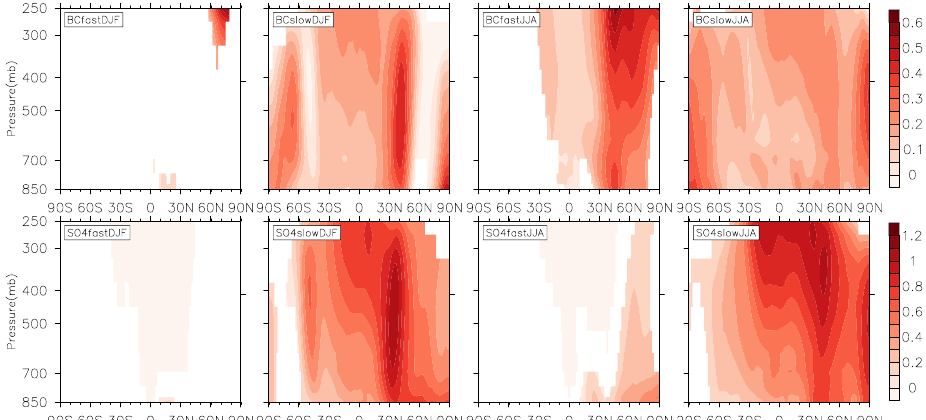
Figure 3. Similar to Fig. 2, but for fast (first and third columns) and slow components (second and fourth columns) of temperature response (in ◦ C). The fast component is calculated by running the atmospheric-only (fixed SST) simulation with perturbed atmospheric compositions, while the slow component is the difference between the total (Fig. 2) and fast components. The color scale for SO 4 is reversed.